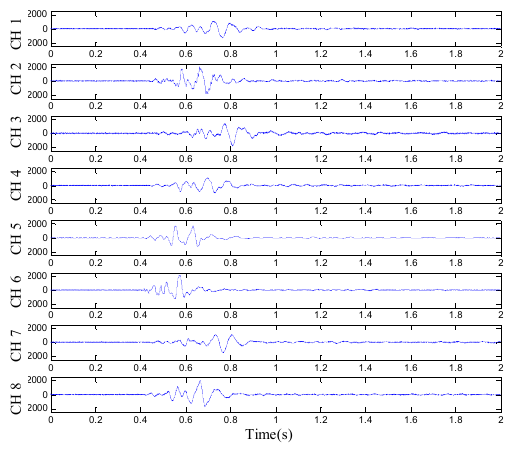
Figure 28. Read data waveform.